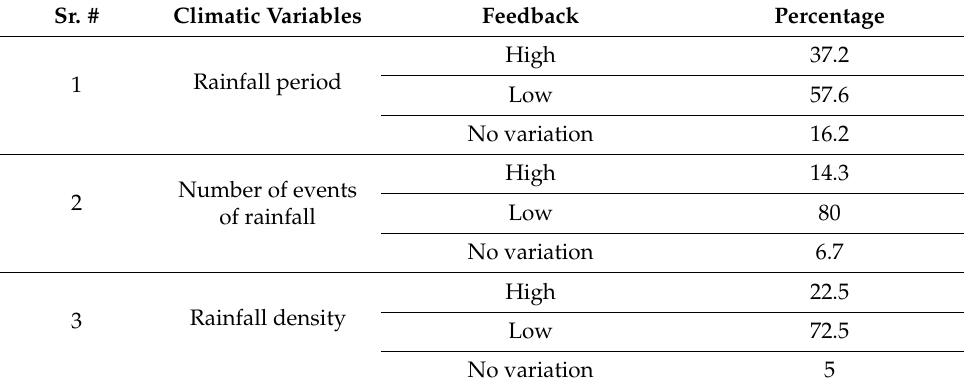
Table 3. Farmers’ observations about rainfall. Sr.